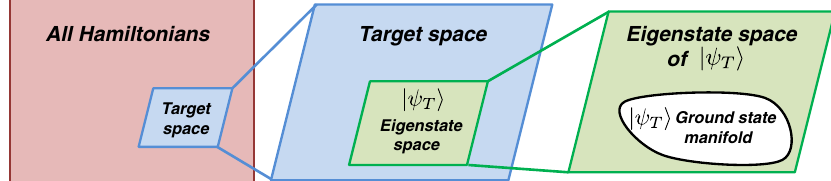
FIG. 2. All Hamiltonians of a finite-dimensional quantum system form a real vector space of Hermitian operators (shown in red). EHC is performed in a target space of Hamiltonians, a physically meaningful subspace of the entire vector space chosen by the user (shown in blue). The output of EHC is the eigenstate space, a subspace of the target space consisting of Hamiltonians that contain a target wave function j ψ T i as an energy eigenstate (shown in green). Using ground-state methods, one can further map out the ground-state manifold, the region in eigenstate space where the target state j ψ T i is a ground state (shown in white).